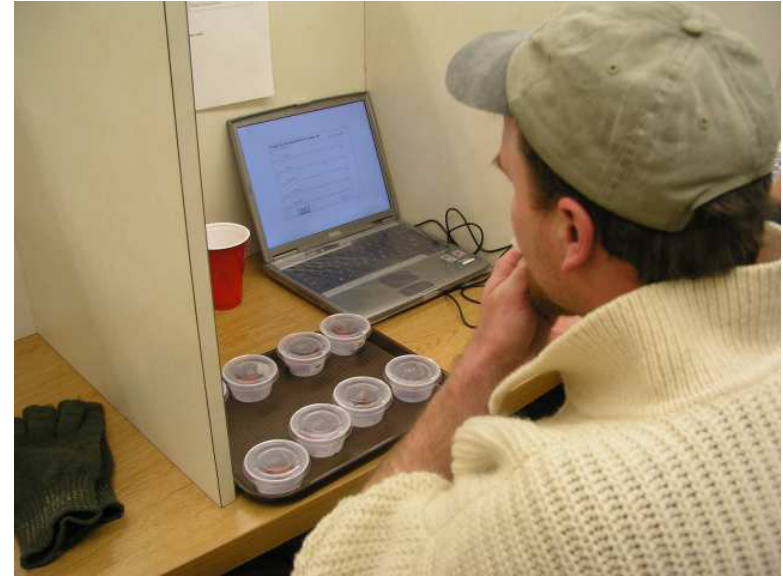
Fig. 3. Sensorisk analys är ett viktigt komplement till teknologiska mätningar av köttkvalitet. En kombination av information från en tränad panel och konsumenttester ger den bästa beskrivningen av produktkvalitet (Foto: Reindeer Research Program, University of Alaska